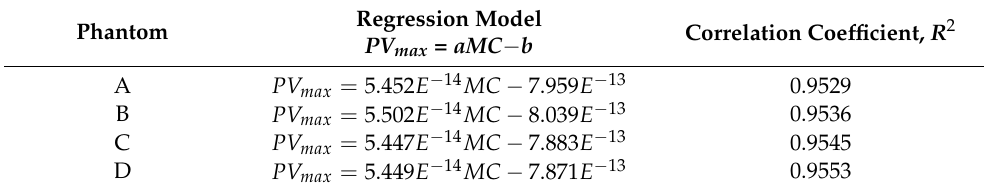
Table 7. Correlation coefficients of the regression model using Tikhonov Regularization algorithm.